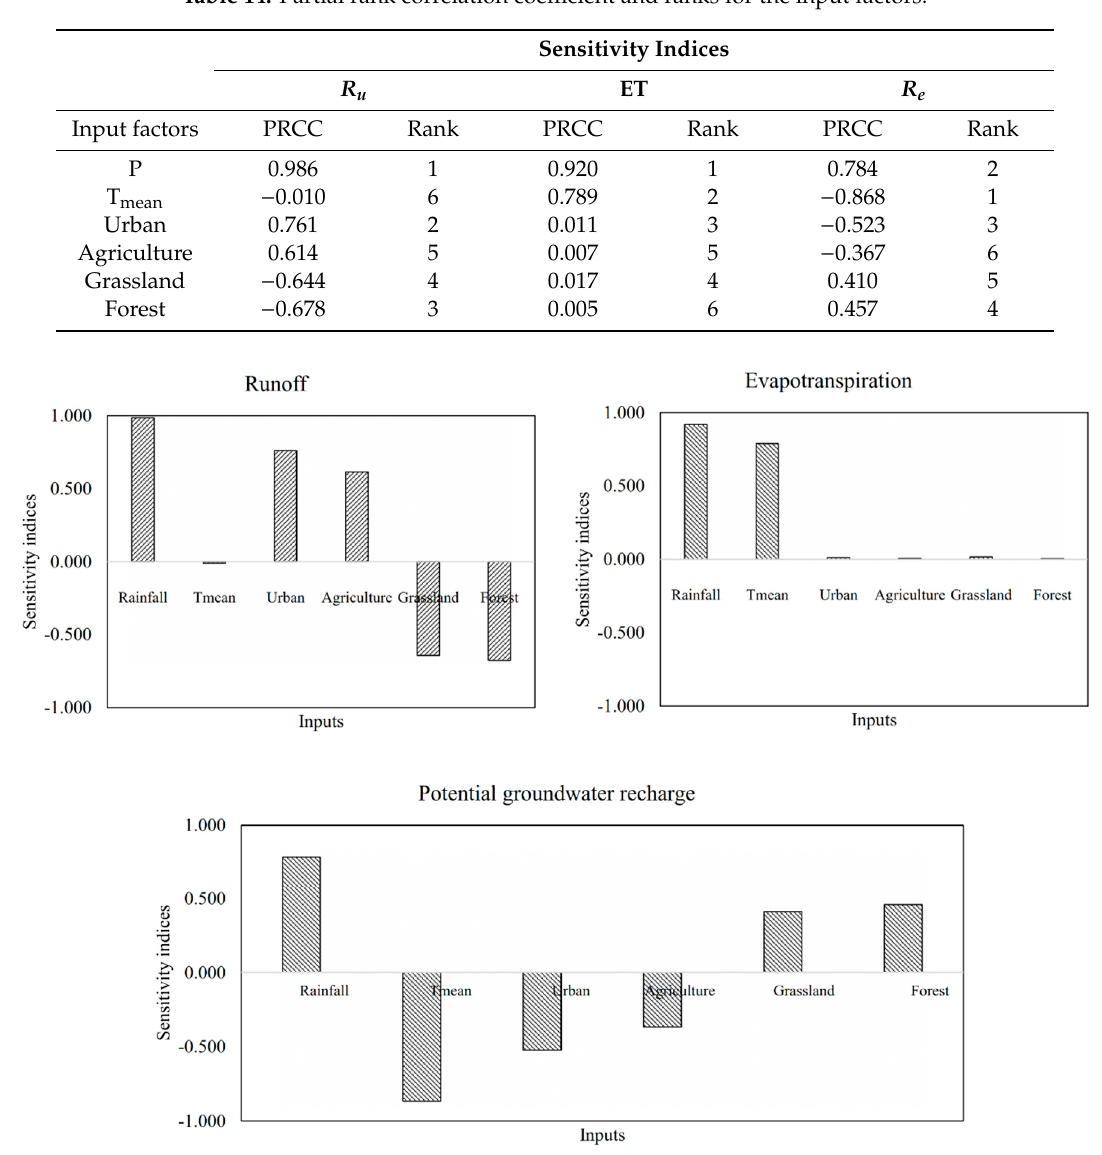
Table 14. Partial rank correlation coe ffi cient and ranks for the input factors.